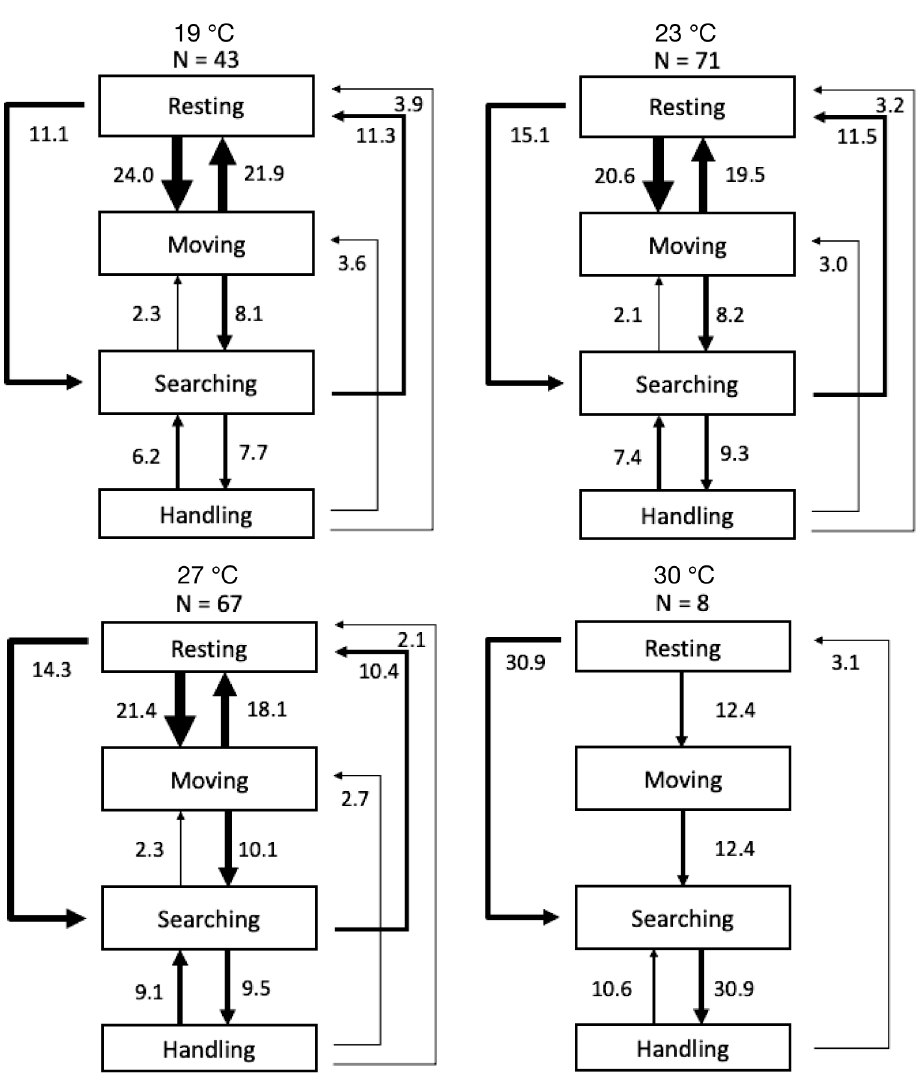
Fig. 3. Kinematic graphs of the behavioral sequences of Rapana venosa under 19, 23, 27 and 30°C. The thickness of the arrows and the numbers beside the arrows indicate the relative frequency (%) between 2 behaviors; N: total number of